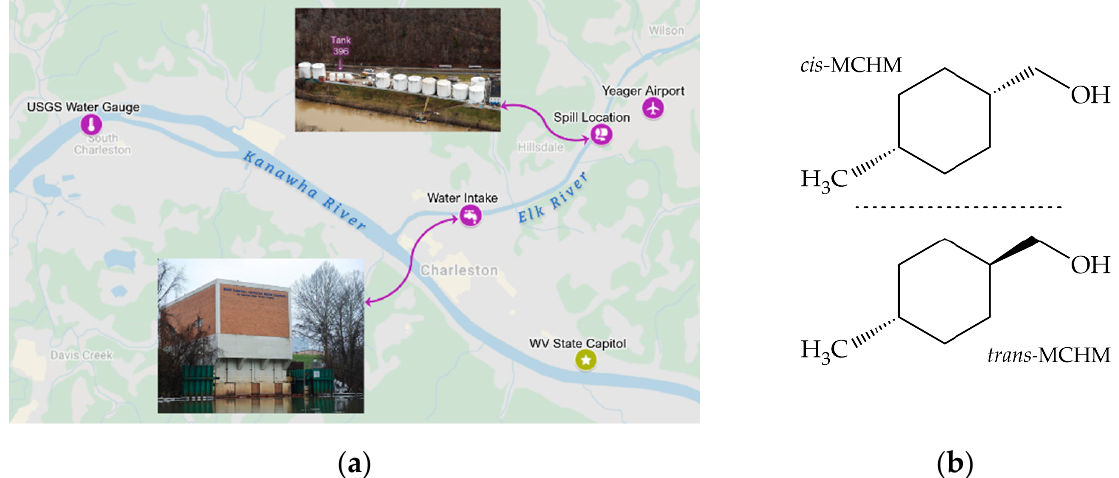
Figure 1. ( a ) Locations in the Charleston, WV area relevant to this study. Base map from Google Maps, inset images from Reference [17]; ( b ) Isomers of 4-methyl-cyclohexane methanol, the major component of the fluid mixture spilled into the Elk River.